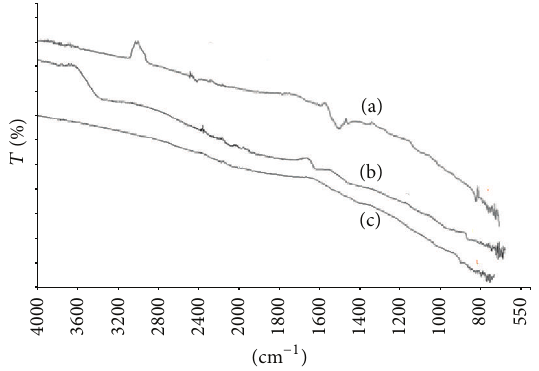
Figure 7: Spectra of (a) the physicochemically treated AC with only microwave application followed by pyrolysis at 700 ∘ C, (b) the physicochemically treated AC with microwave and ultrasound applications together followed by pyrolysis at 700 ∘ C, and (c) the Pb(II)-loaded